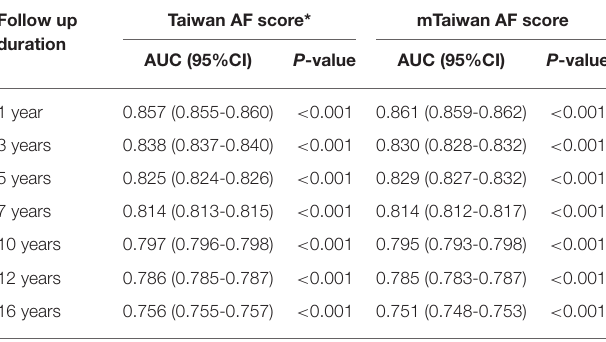
TABLE 2 | AUCs of Taiwan AF score and mTaiwan AF score in the prediction of AF after different follow-up durations. Follow up Taiwan AF score* duration